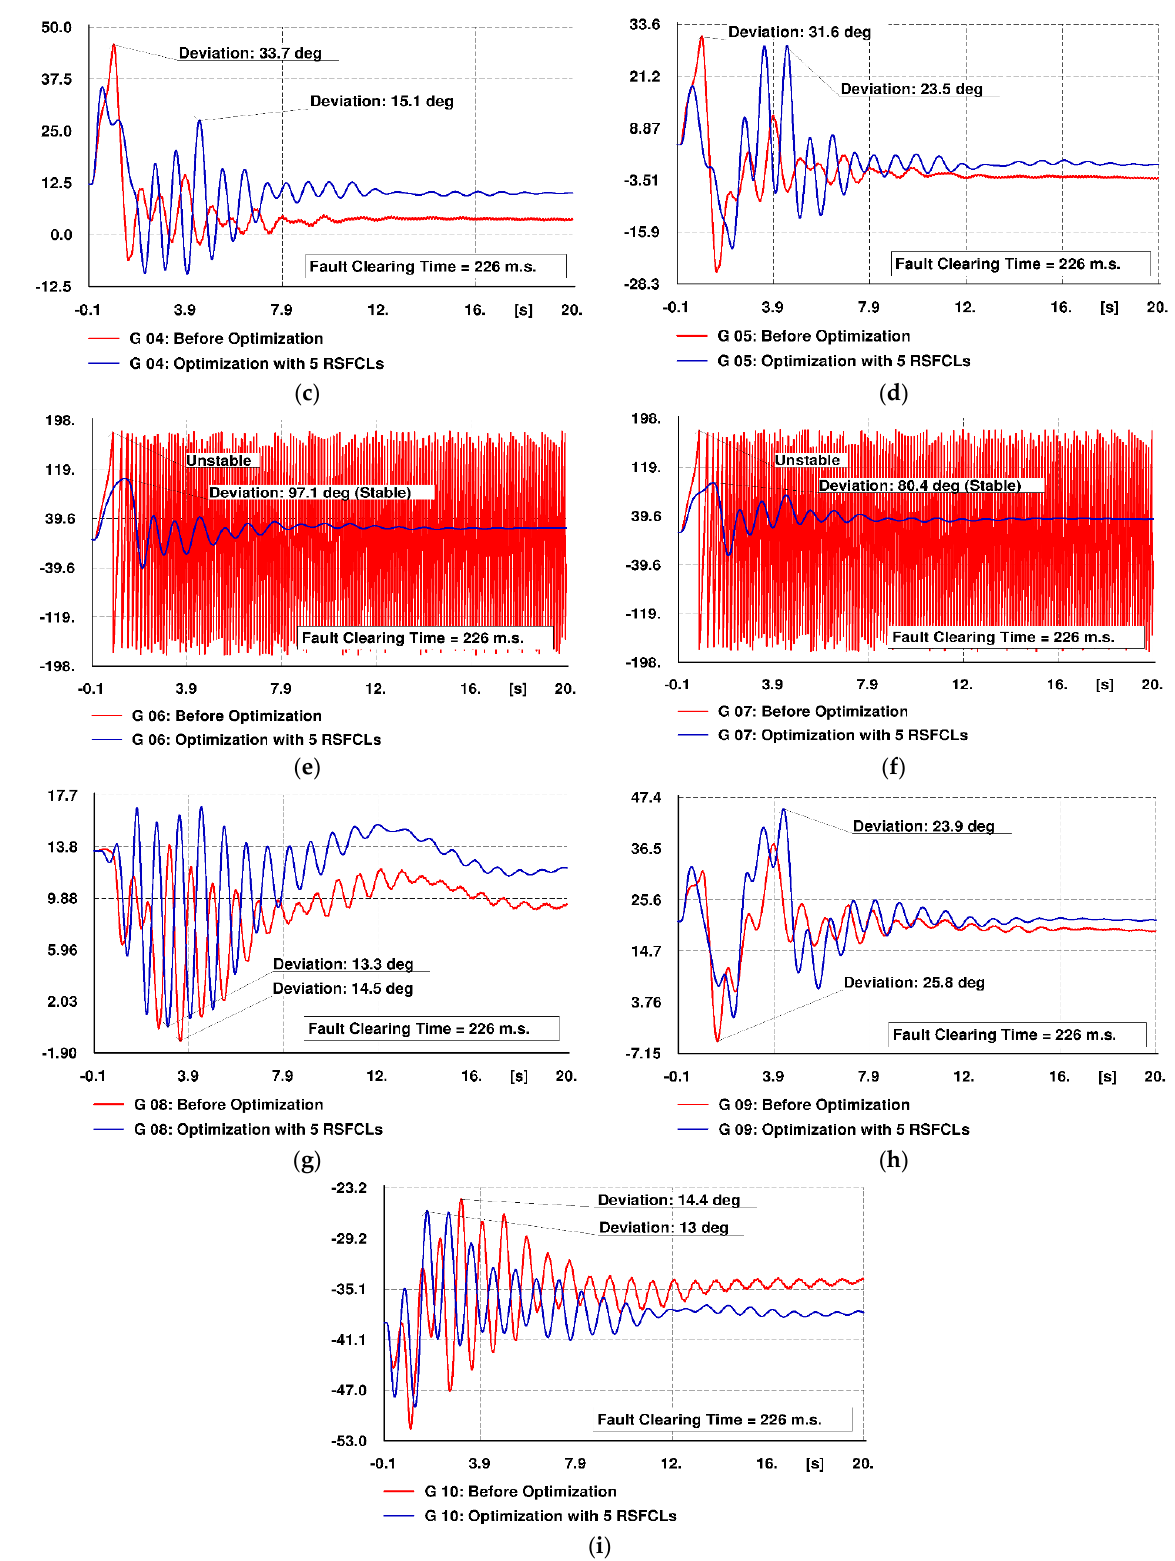
Figure 14. Rotor angle oscillation of generators in Scenario 2 with reference to the reference machine “with” and “without” optimized RSFCLs. ( a ) Generator G1, ( b ) Generator G3, ( c ) Generator G4, ( d ) Generator